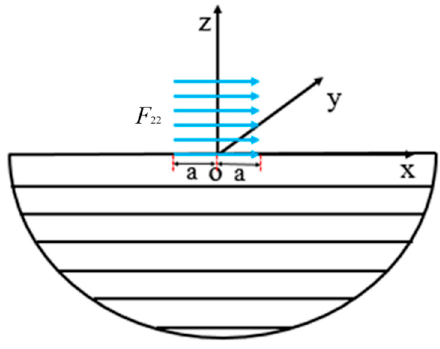
Figure 5. Transversely isotropic elastic half ‐ plane surface subjected to horizontally distributed stress.